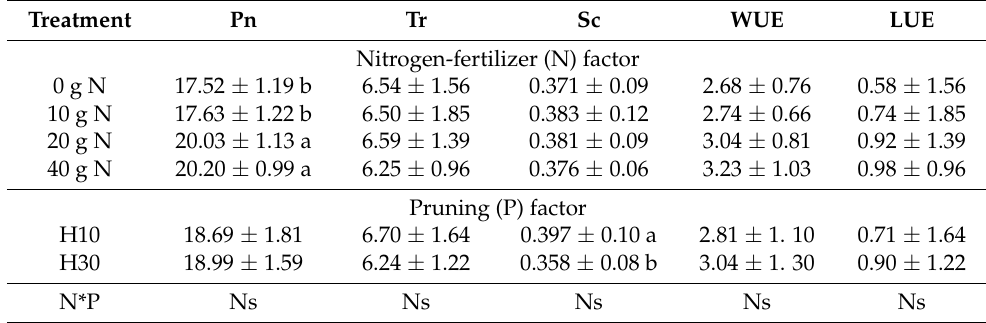
Table 4. Kaffir lime physiological response under different pruning levels and nitrogen-fertilizer